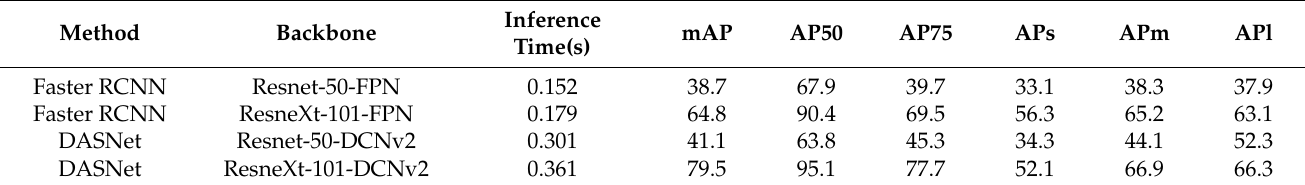
Table 4. Detection mAP (%) for Faster RCNN and DASNet in Different Backbones.